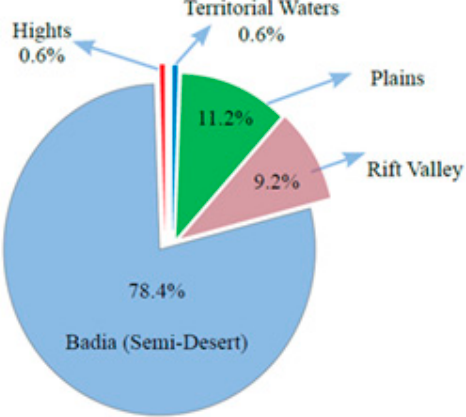
Figure 4. Kingdom of Jordan area by topography [11].